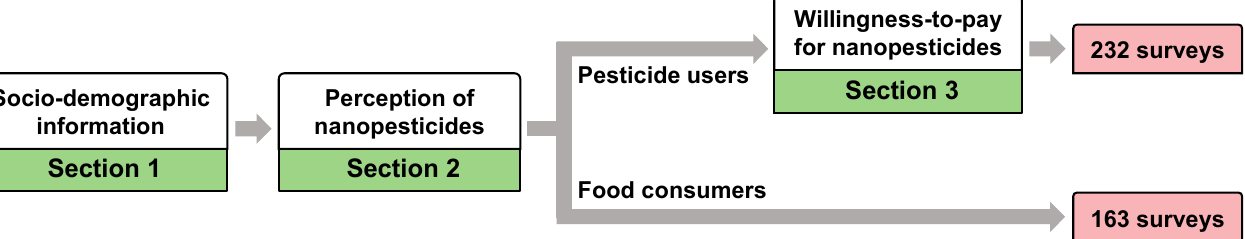
Figure 1. Flowchart for the questionnaire survey.